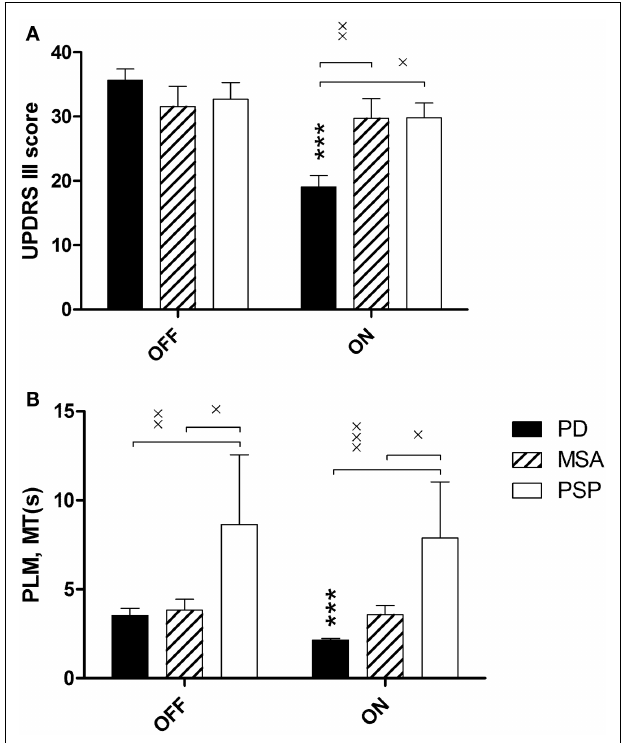
FIGURE 3 | (A) UPDRS III scores before (OFF) and after (ON) 200mg L -DOPA, stratified over the three diagnoses: Parkinson’s disease (PD), multiple system atrophy (MSA), and progressive supranuclear palsy (PSP). (B) PLM mean movement time, MT(s), duration. Main effects of diagnosis and treatment state were analyzed with repeated measure two-way ANOVA followed by Bonferroni corrected t -tests where *** p < 0.001, PD OFF vs. PD ON, * p < 0.05, ** p <